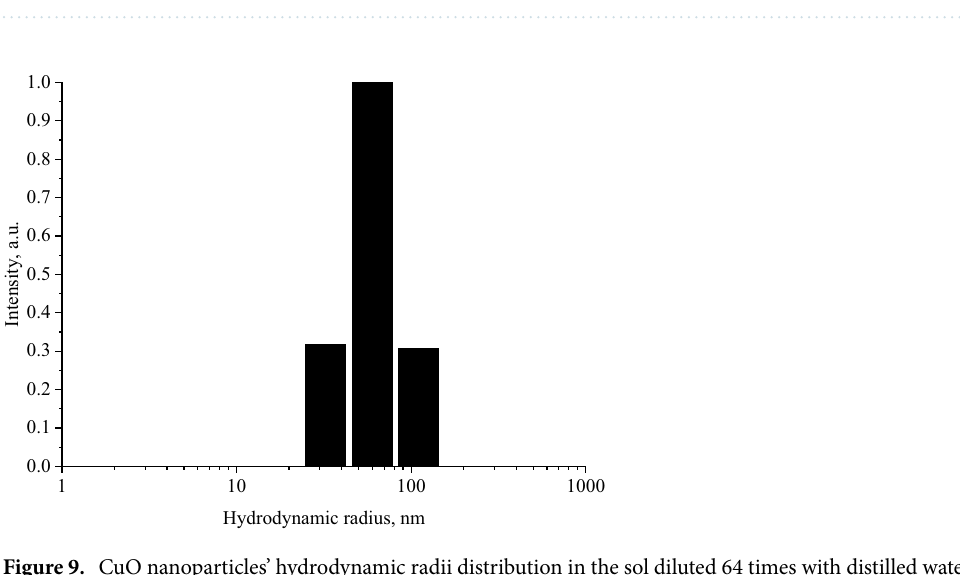
Figure 8. IR-spectra of CuO nanoparticles (1) and gelatin (2) samples.